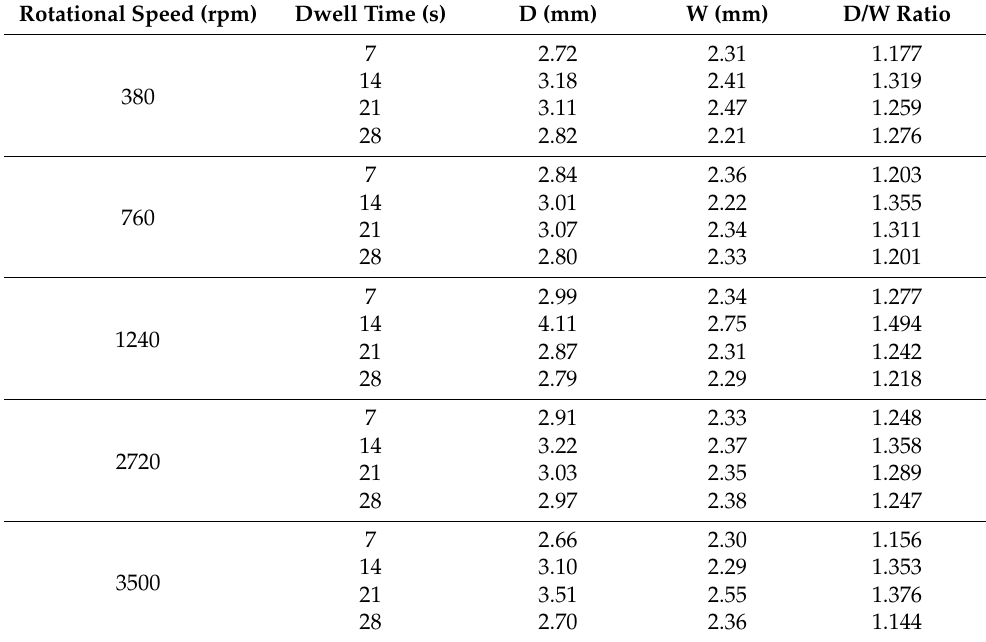
Table 4. D/W ratio of FSSW by SSM 6061 aluminum